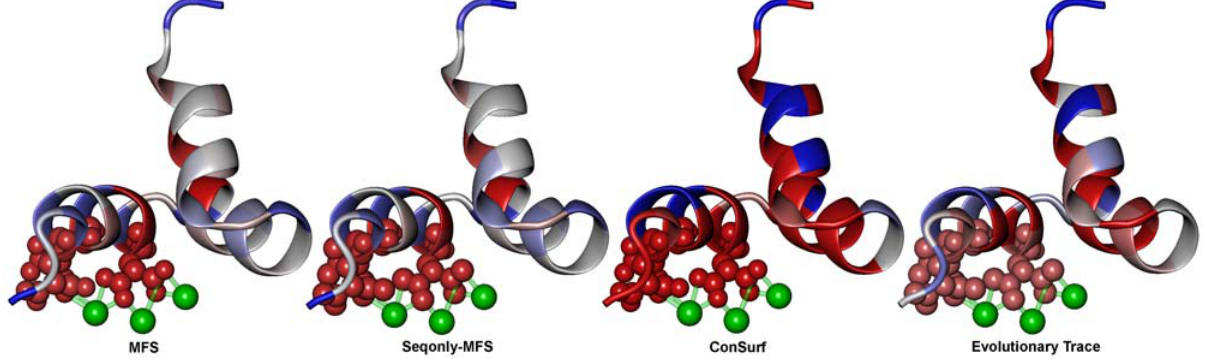
Figure 5. Prediction of residues with rare function not represented in the training sets. MFS was trained on a set of residues experimentally characterized to participate in canonical catalytic functionalities and protein-ligand interfaces. Protein binding to biomineral surfaces is a rare function and poorly understood process, for which the only diffraction structure available is osteocalcin binding metal ions (depicted as green spheres with ionic bonds to the c -carboxy glutamic acid (gla) residues in transparent green tube) (PDB identifier: 1q8h). The three gla residues of osteocalcin (represented as spheres, similar to the target residues in Figure 3 above) previously shown to bind the hydroxyapatite surface of bone are clearly selected by MFS within the top six of 49 residues, with or without knowledge of structural and post-translational modification to these residues. These residues are selected within the top eight by ConSurf, with much lower discrimination from scores for the other residues in osteocalcin. None of these residues are selected within the top-10 by ET. This example demonstrates the applicability of MFS to make highly accurate and specific predictions for proteins of vastly diverse functions.